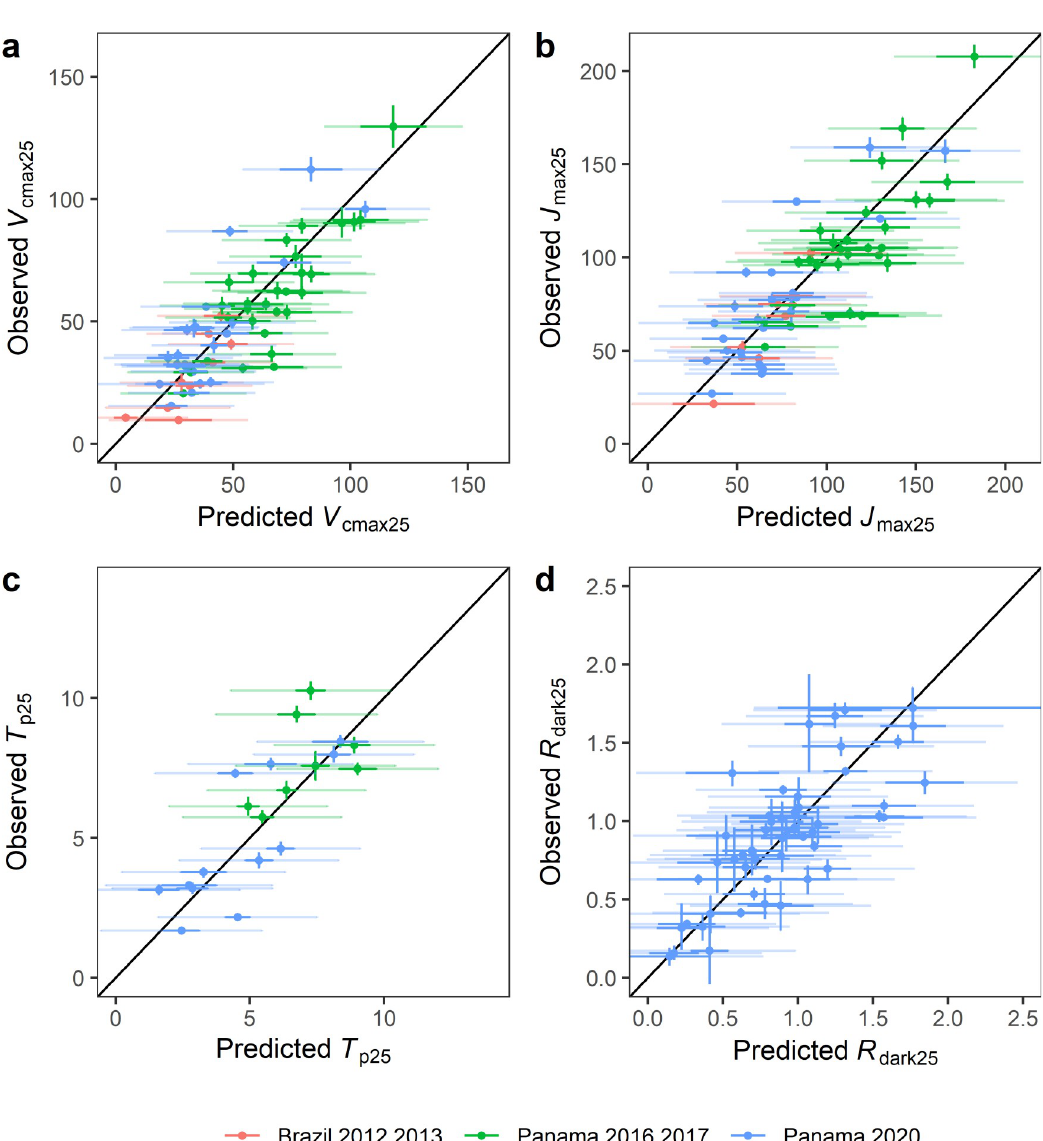
Fig 3. Observed vs predicted value of the core photosynthetic parameters using PLSR models on the random split validation dataset. The points correspond to the mean value of the variables, the vertical lines correspond to the interval of confidence of the parameters estimated by the fitting of the A - C i curves. The horizontal dark lines correspond to the interval of confidence of the PLSR models, and the light lines correspond to the interval of the prediction. The black line corresponds to y = x.